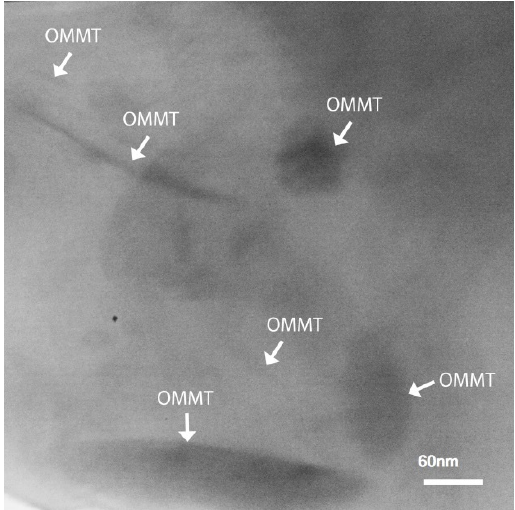
Figure 6. A representative TEM image of the OMMT-modified rubber. The arrows indicate the randomly orientated OMMT layers.